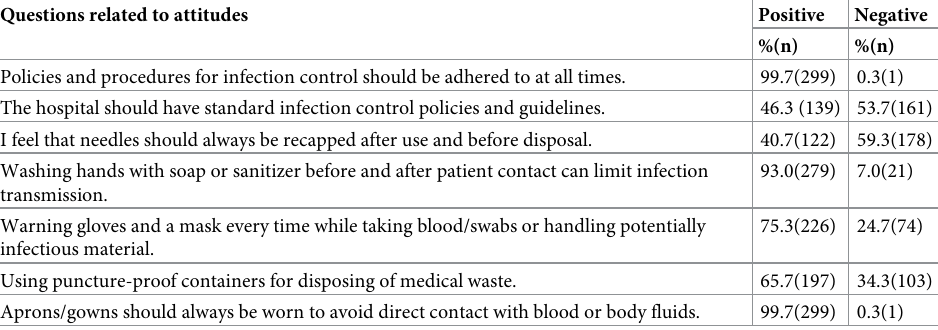
Table 3. Attitude of the nurses toward infection prevention and control, universal precautions, disinfection, ster- ilization (N = 300). Questions related to